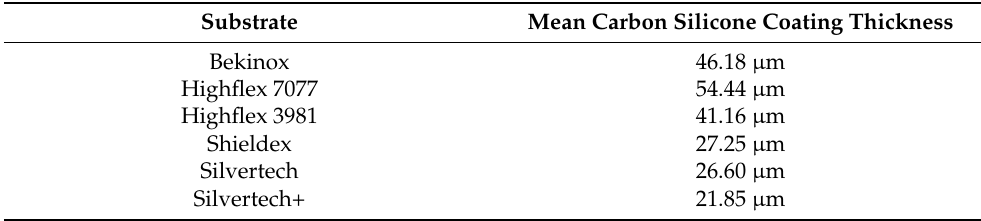
Table 2. Coating thickness calculated by averaging light microscopic cross-section measurements of the